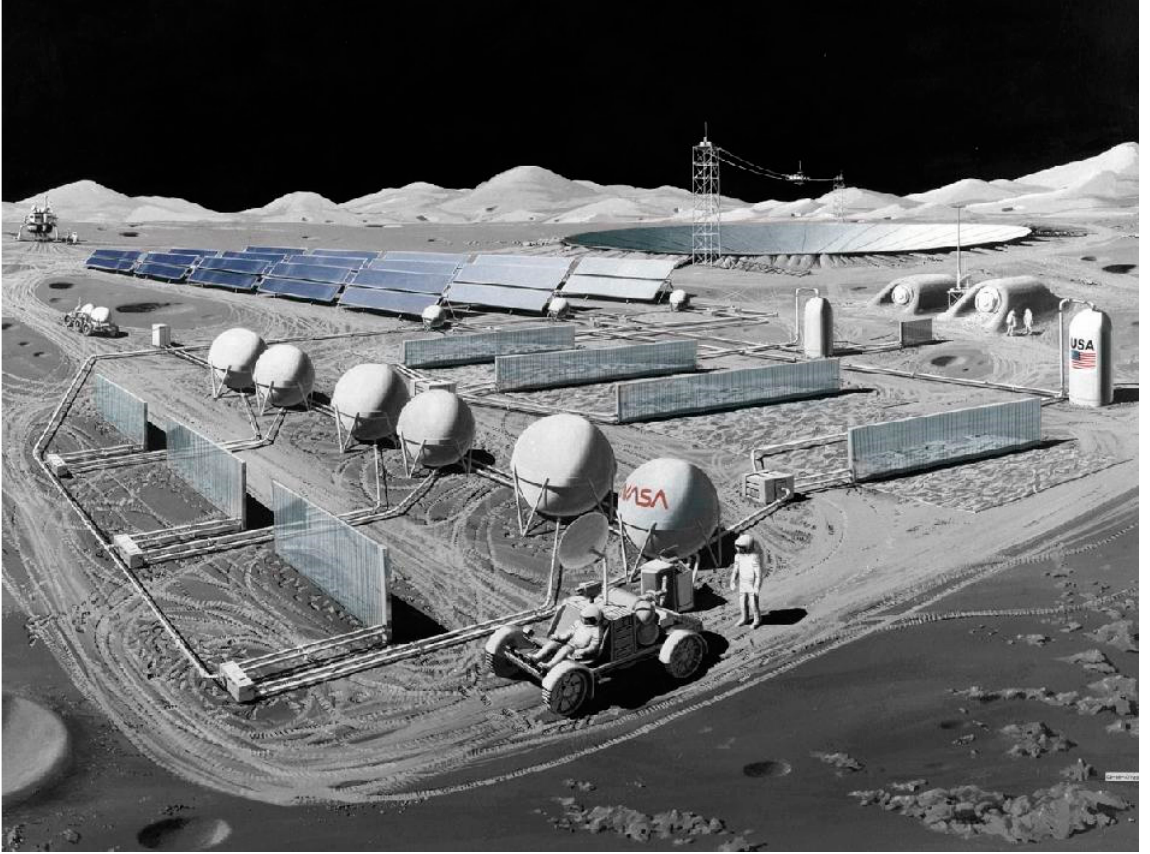
Figure 3. Concept of manned lunar observatory.